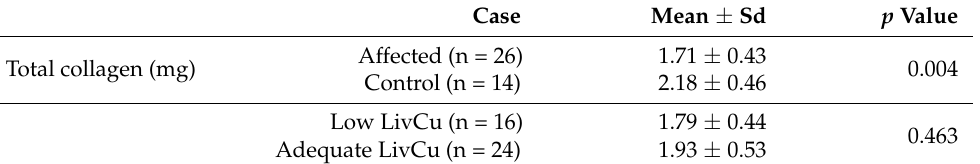
Table 3. Mean ± sd of total collagen content in cows comparing humeral fracture status (affected vs. control) and the liver copper concentration status (low vs. adequate); LivCu: liver copper concentration.